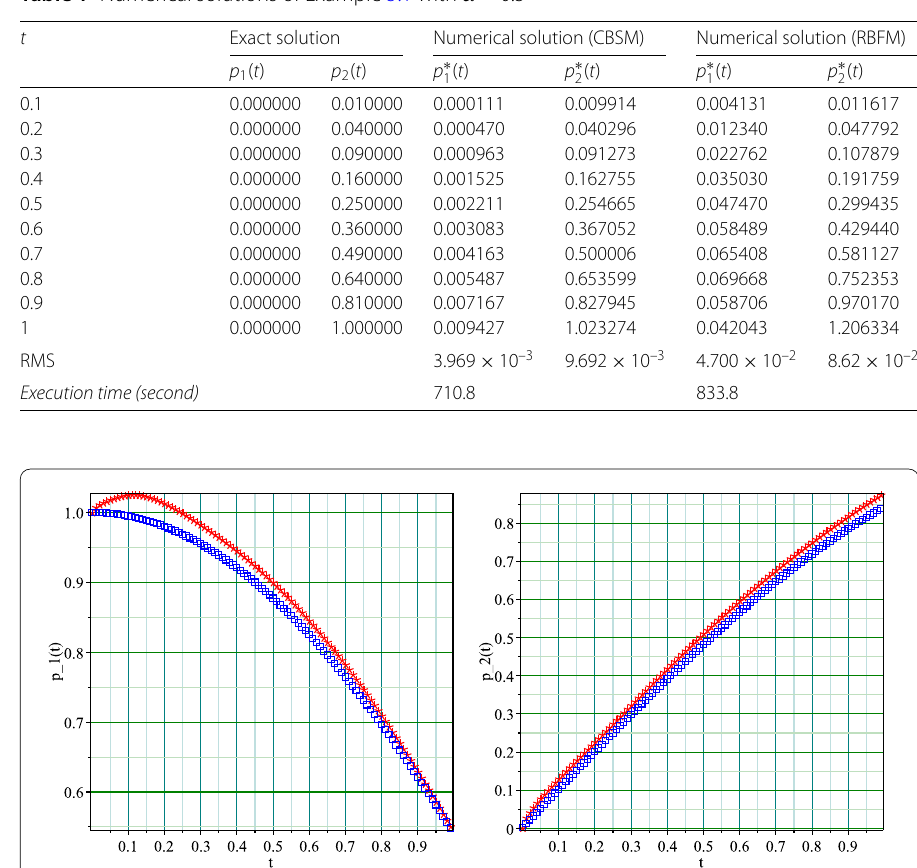
Table 1 Numerical solutions of Example 5.1 with α =